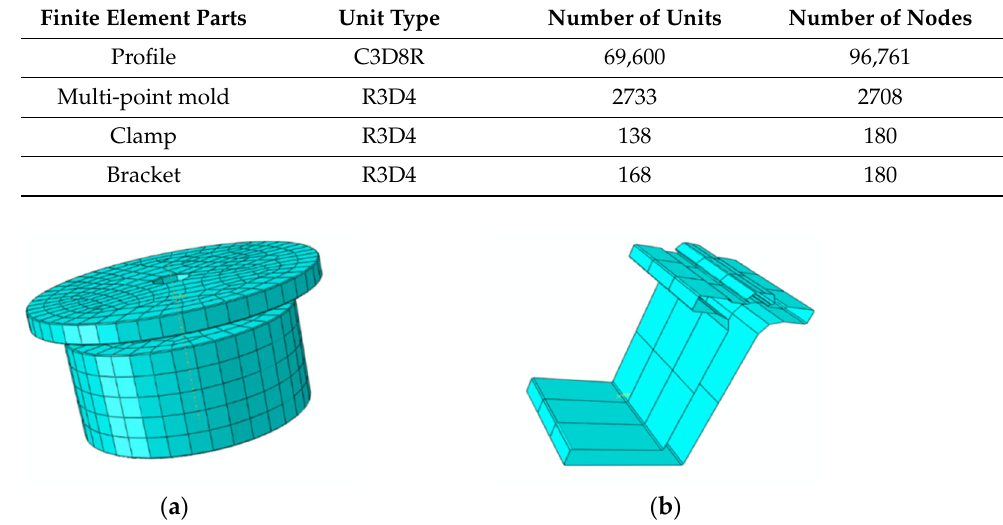
Figure 4. The finite element model: ( a ) the roller die, ( b ) the clamp.